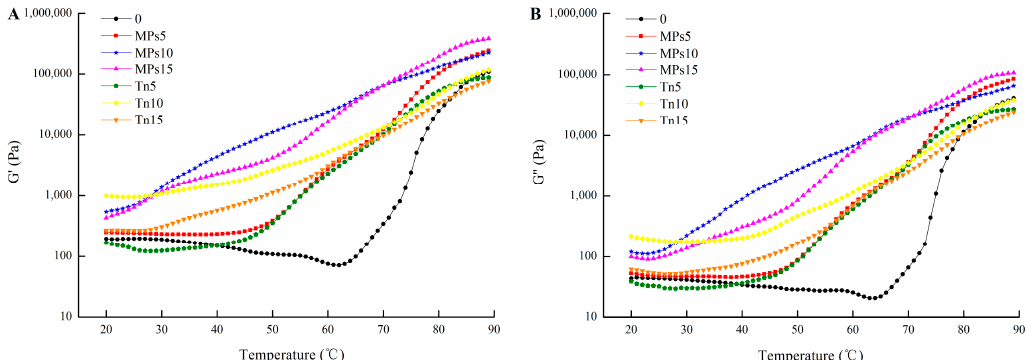
Figure 3. Storage modulus (G ′ ) ( A ) and loss modulus (G ′′ ) ( B ) during heating of gels containing MP- or Tween 80-stabilized camellia seed oil emulsions. 0 = control; MPs5, MPs10, and MPs15 = gels with MP-stabilized emulsions homogenized at 5000, 10,000, and 15,000 rpm, respectively; Tn5, Tn10, and Tn15 = gels with Tween 80-stabilized emulsions homogenized at 5000, 10,000, and 15,000 rpm,